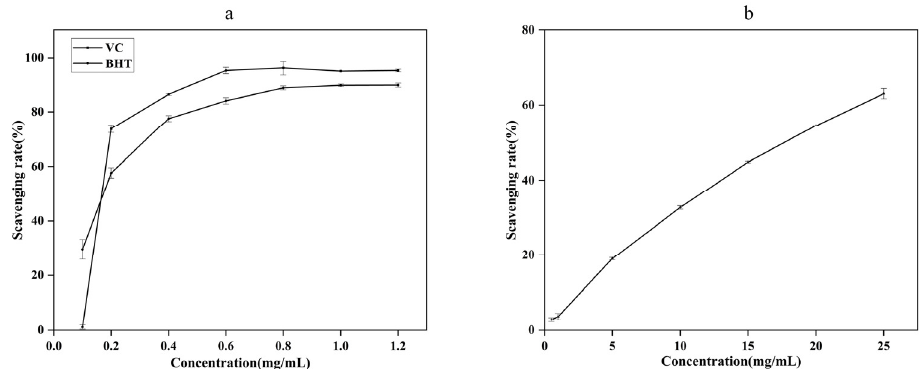
Figure 4. The clearance ability of VC, BHT ( a ) and AgEo ( b ) for DPPH radical.